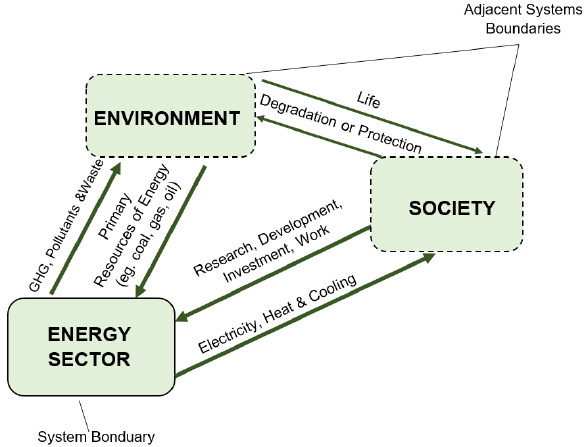
Figure 1. The complex relationship between energy sector, environment and society of system representation (own elaboration based on [37]).